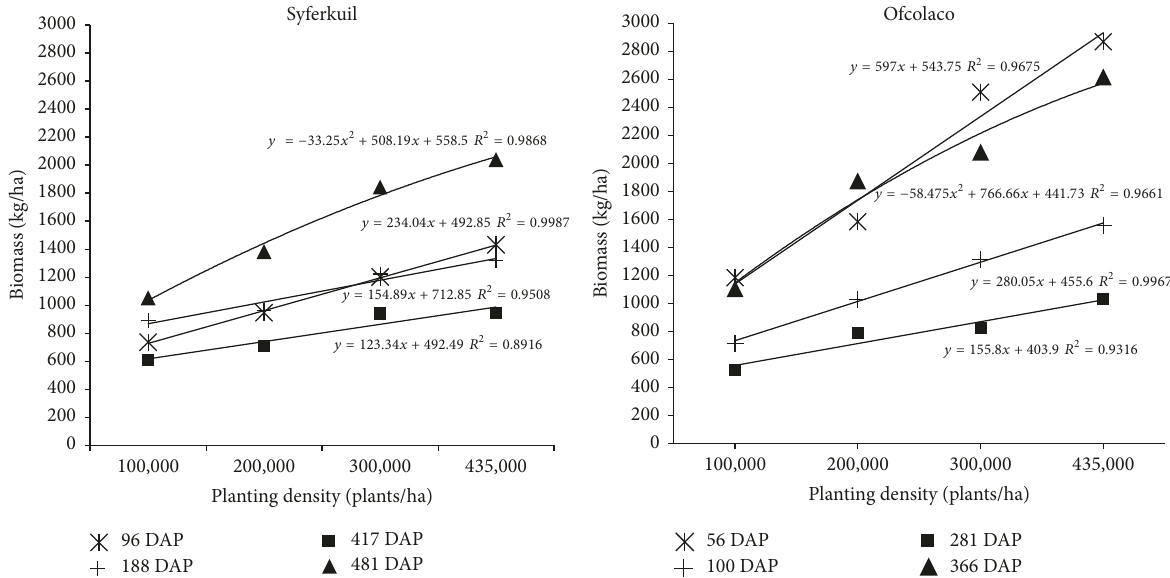
Figure 2: Effect of planting density on moringa biomass production at four harvest intervals at both study sites across the four seasons. DAP: days after planting.